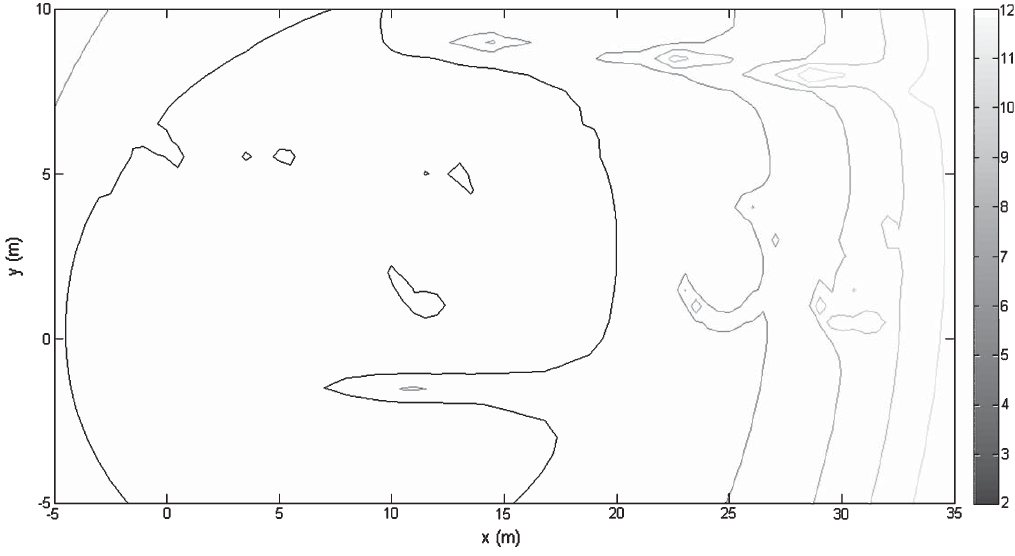
Fig. 12. 2D potential fields mapped by the mobile robot (top view), using the last γ